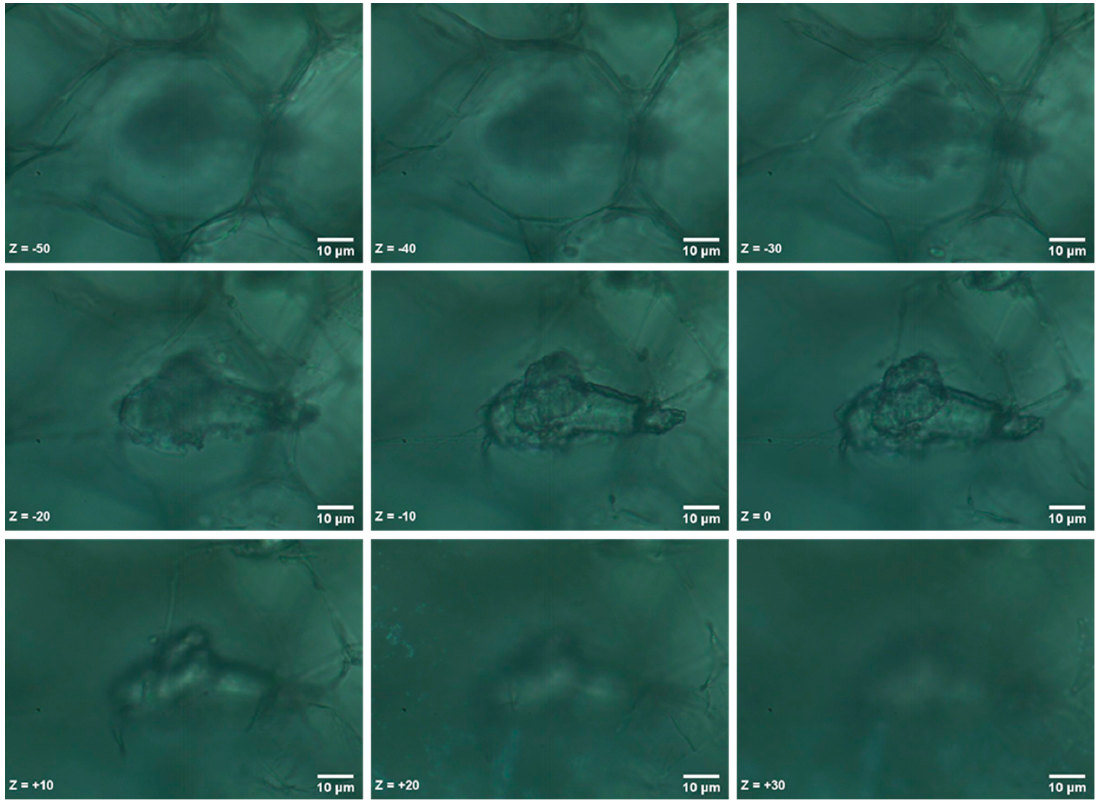
Figure 6. Confocal localization of an ABS MP at different Z positions within the root